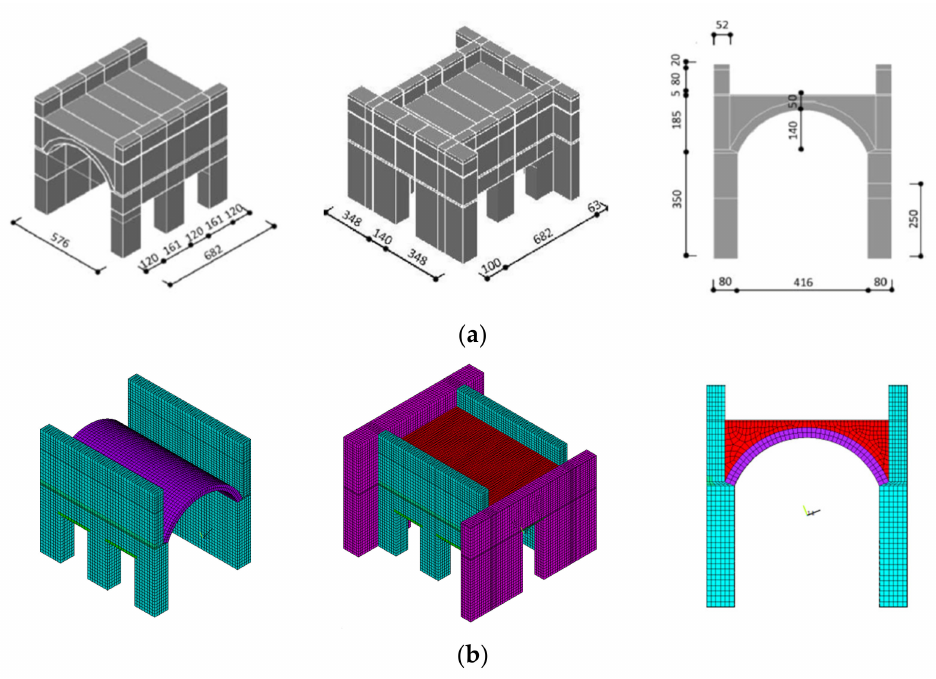
Figure 17. ( a ) Views and dimensions of the geometrical model; ( b ) FEM structural model. Table 8 summarises all examined configurations, for each model. Table 8. Examined configurations and percentage of seismic actions transferred to the transversal walls (last column). Cfg